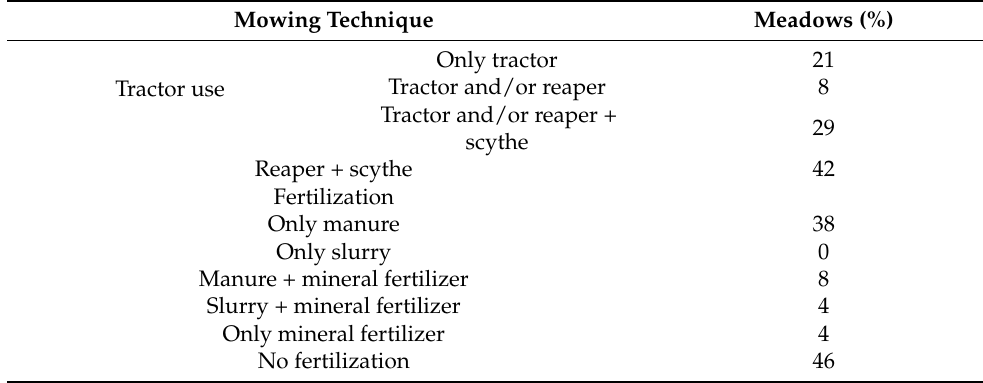
Table 1. Results from the interviews for fertilization and mowing technique (Source Garc í a and Garc í a, 2017 [24]).